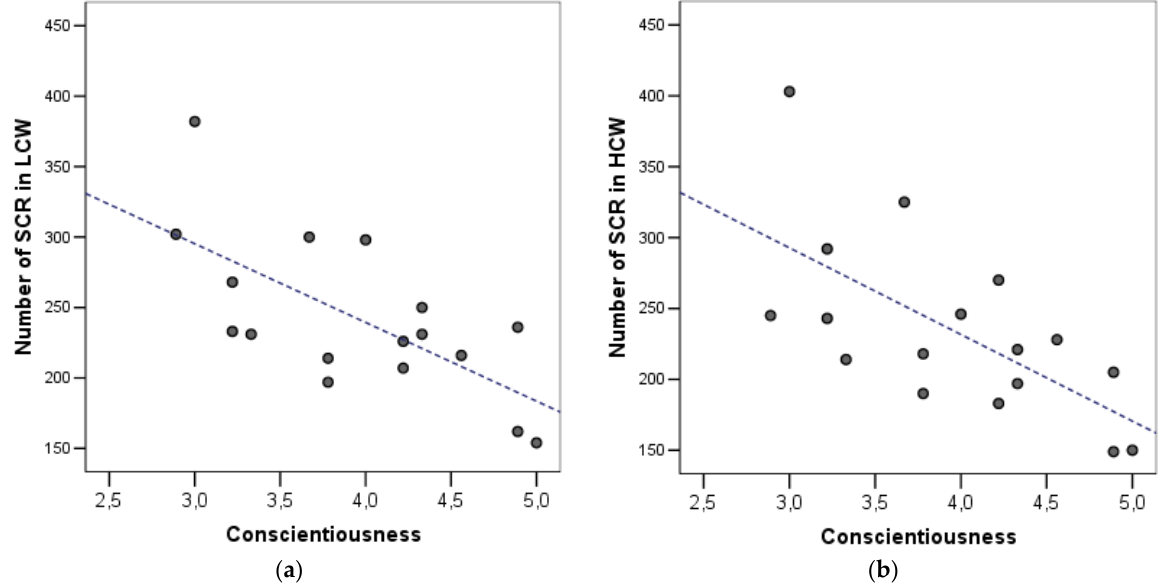
Figure 3. Relation between the number of phasic skin conductance responses SCR under stressful condition and consci- entiousness for: ( a ) low cognitive workload (LCW); ( b ) high cognitive workload (HCW).